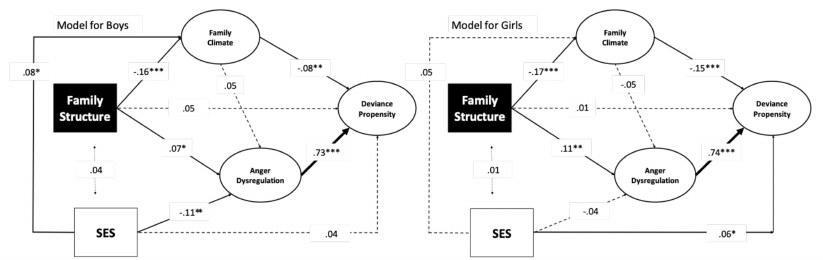
Figure 4. Multigroup analysis of the model tested with gender as a grouping variable, controlling for SES. Notes: *** p < 0.001; ** p < 0.01; * p <